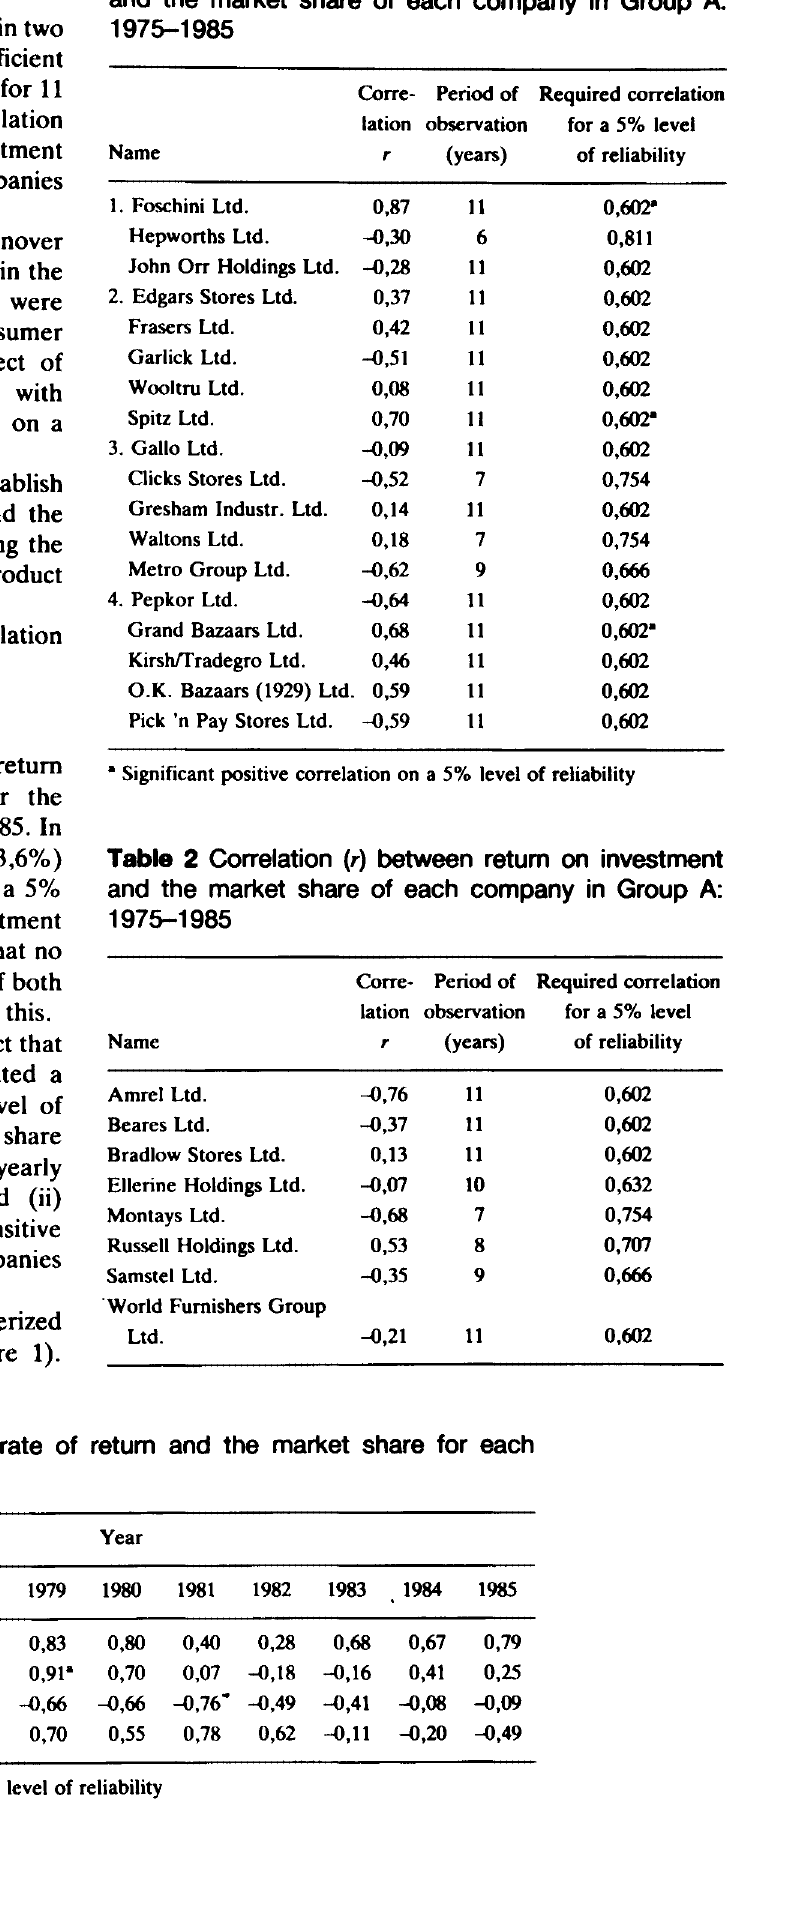
Table 1 Correlation (r) between return on investment and the market share of each company in Group A: 1975-1985